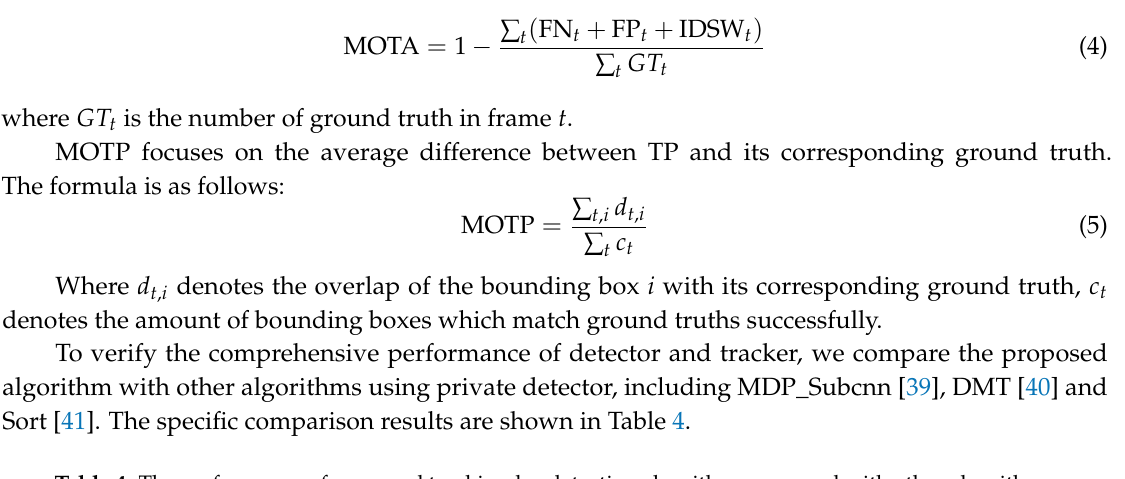
Table 4. The performance of proposed tracking-by-detection algorithm compared with other algorithms in 2DMOT2015 dataset. The green and yellow colors indicate the best and the second best algorithm in each